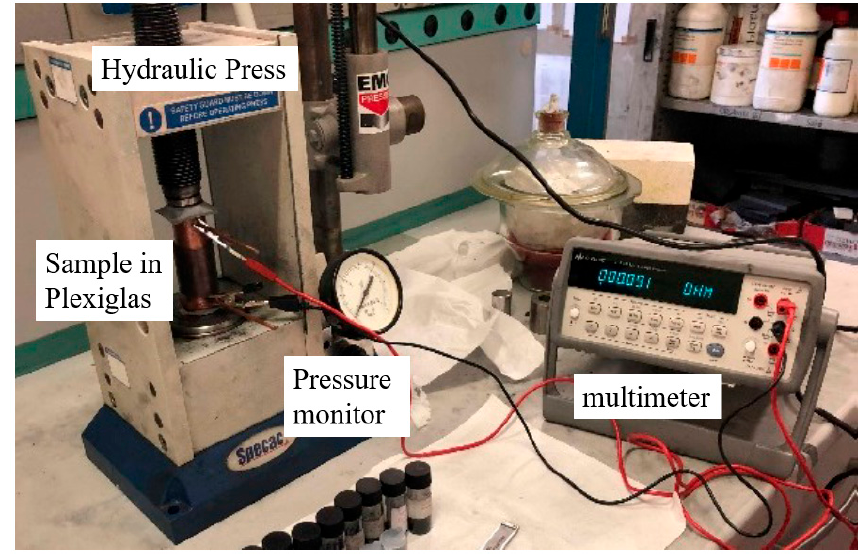
Figure 1. Measurement setup for the conductivity study of carbon fillers.